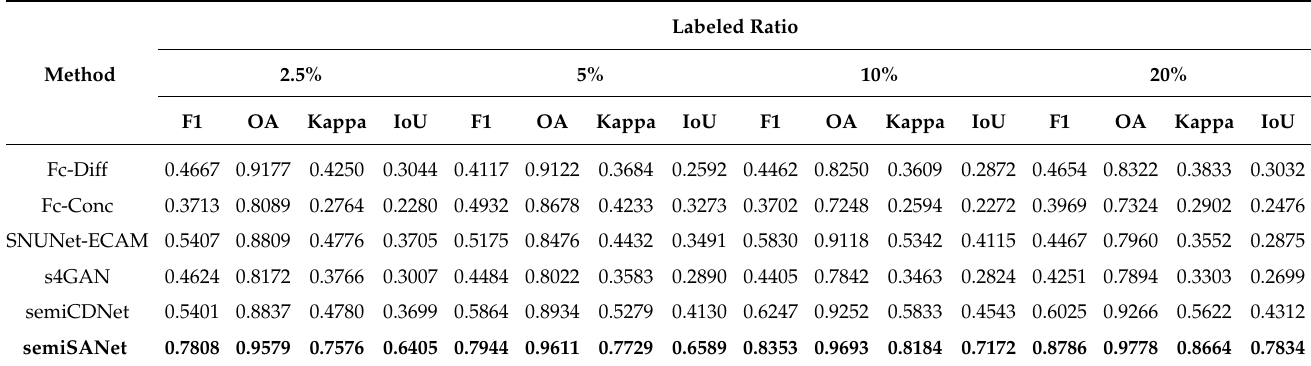
Table 3. The experimental results on the WHU